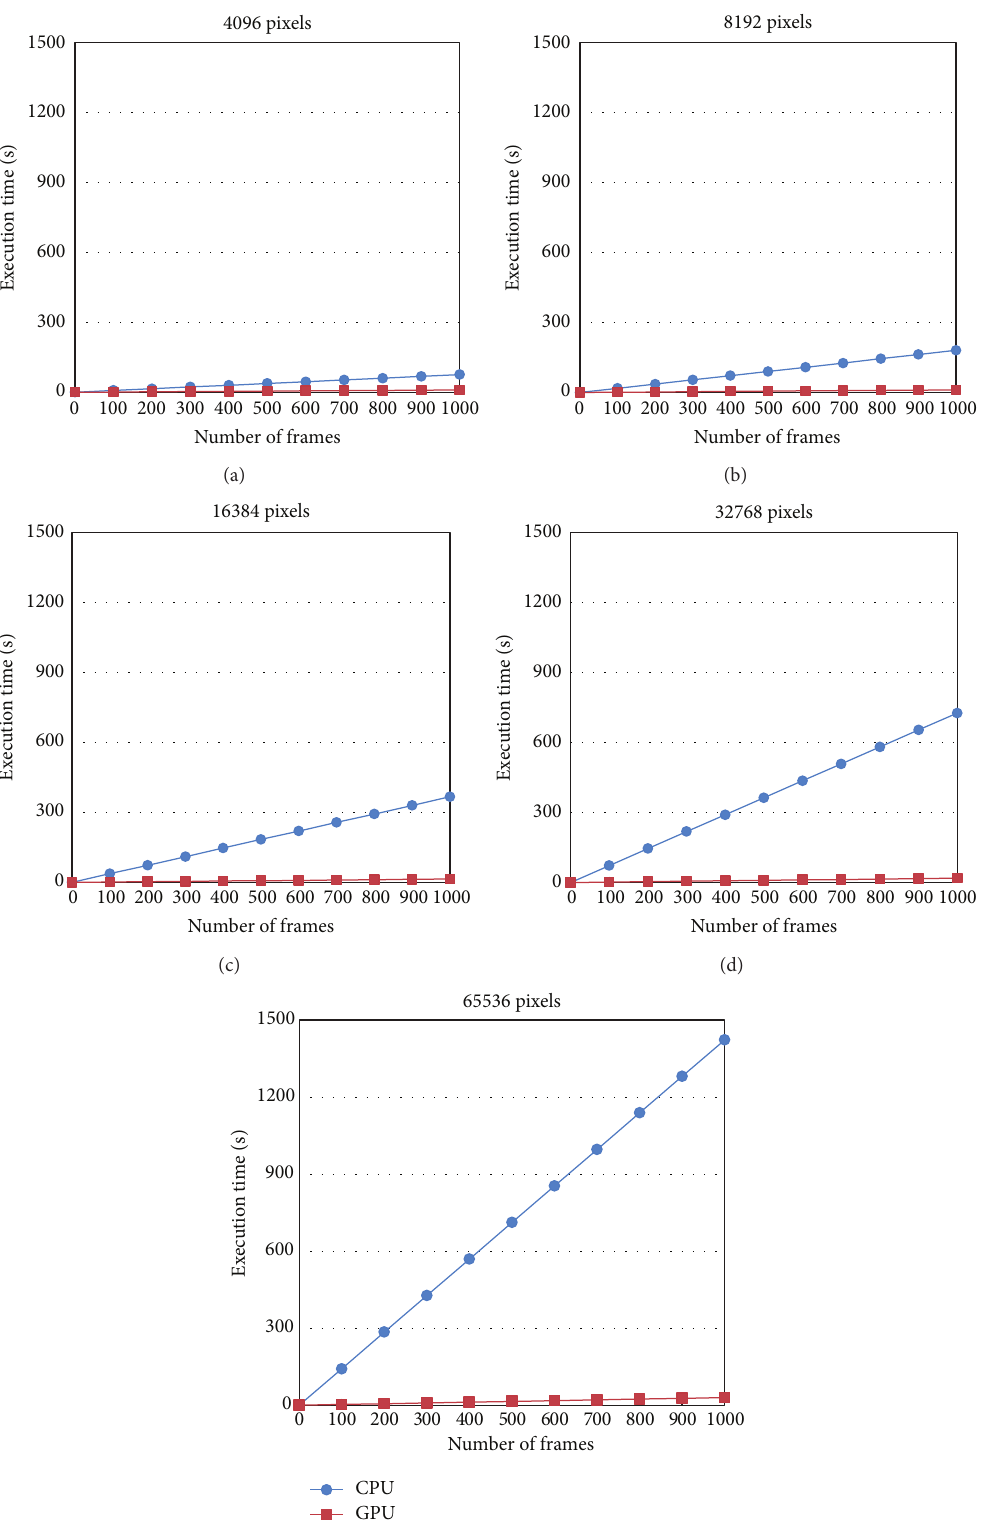
Figure 6: The execution times of the CPU serial algorithm and the GPU parallel algorithm increase with the number of frames on different data